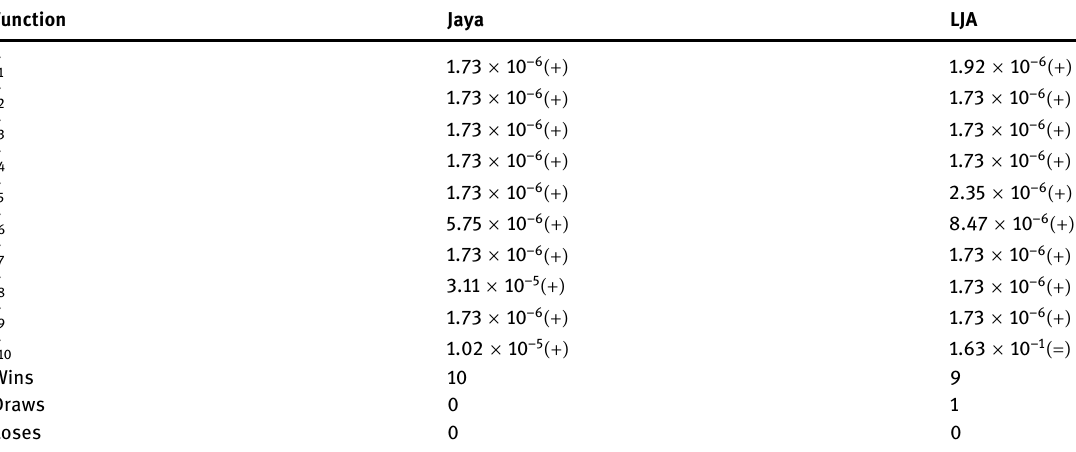
Table 6: The CEC 2020 ( = D 10 ) statistical analysis showing the Wilcoxon test p - value